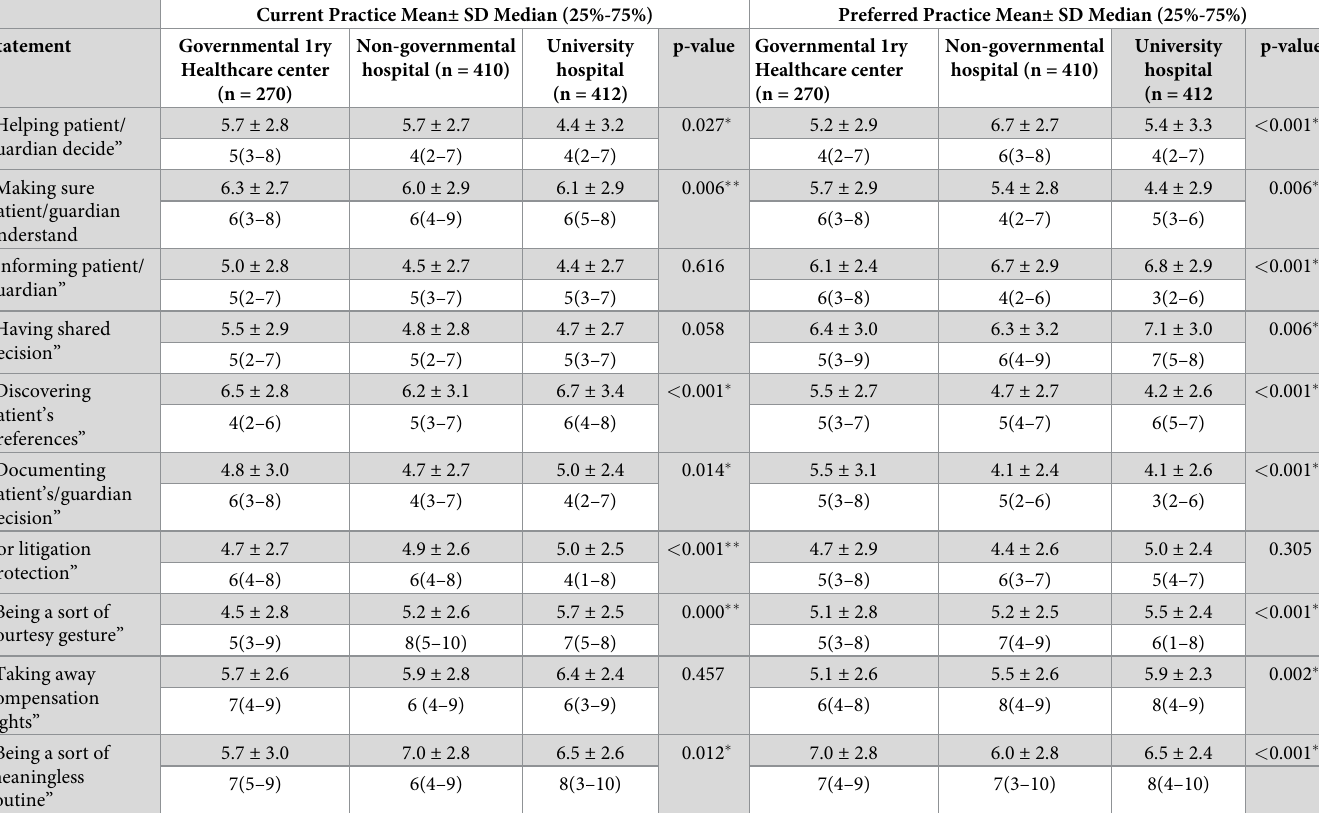
Table 3. Comparison between patients’ perceptions of the current and preferred purposes of the IC practices between the study facilities.